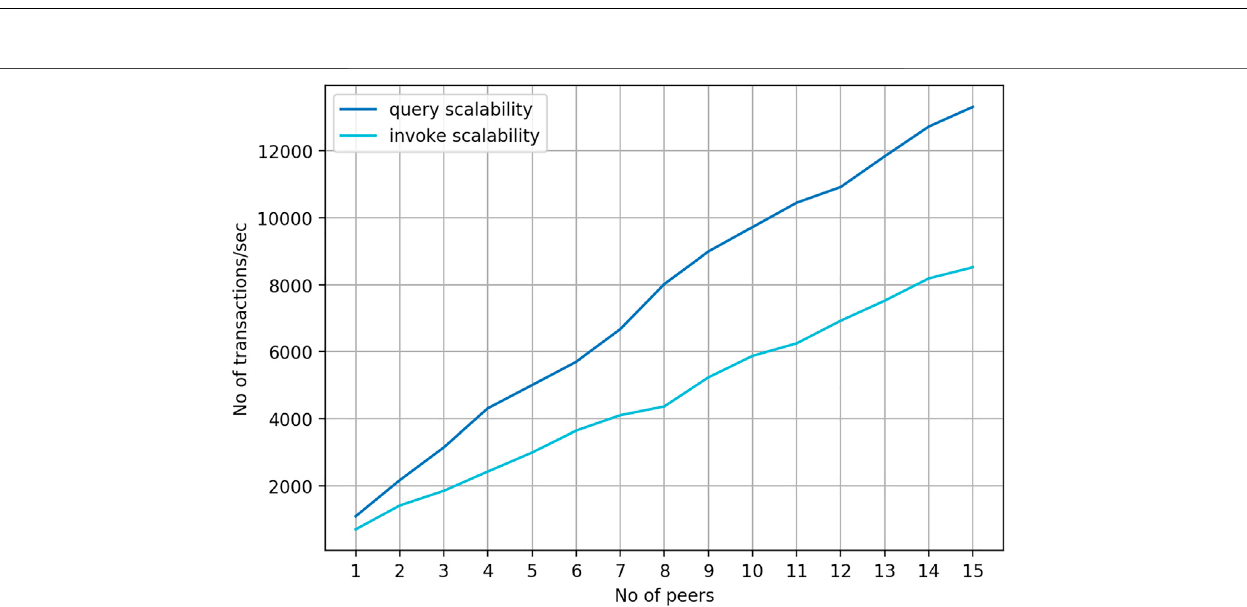
FIGURE 7 | Invoke/query transaction scalability (per second) over the number of blockchain peers in the network.